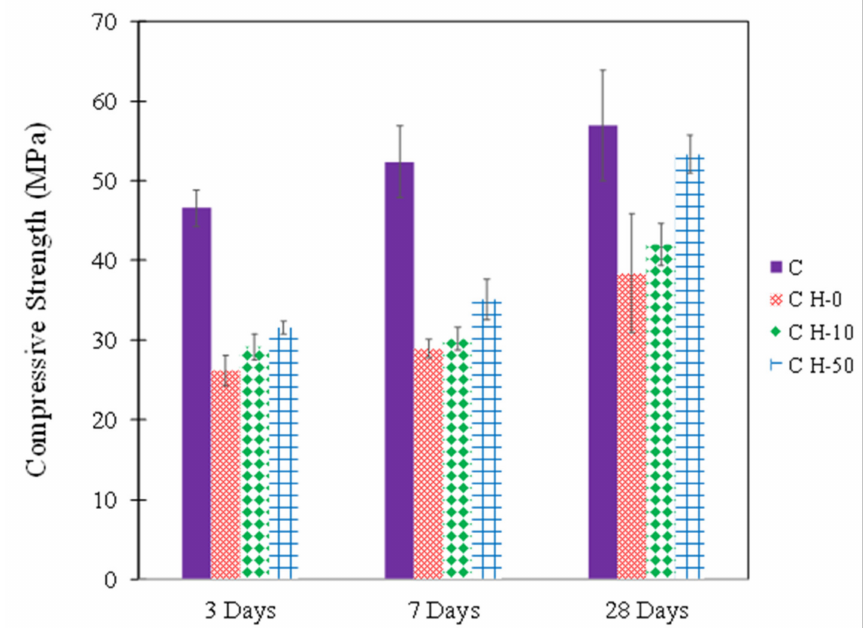
Figure 4. Compressive strength of the control cement paste and the pastes containing hydrogels at different